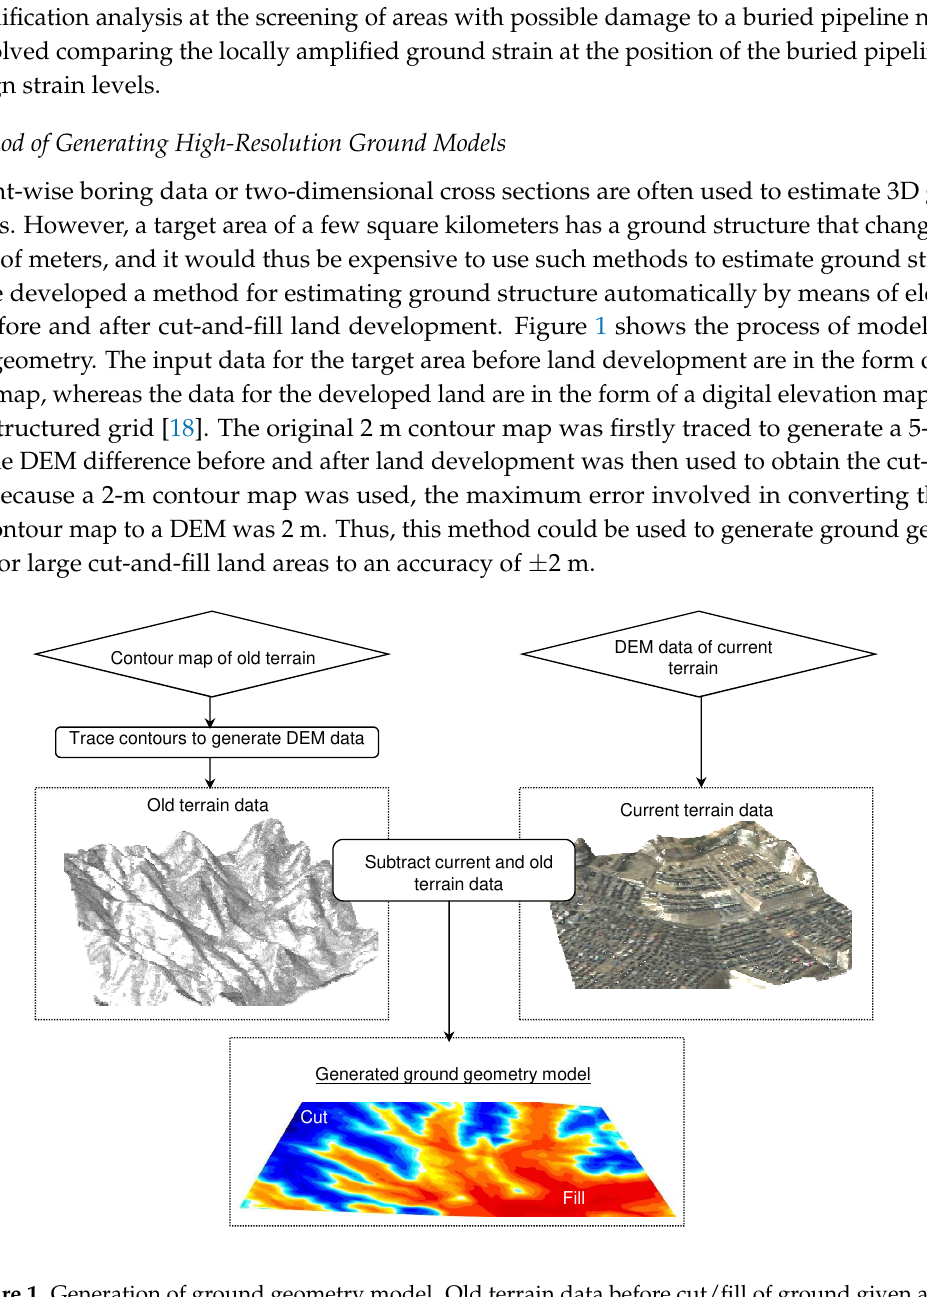
Figure 1. Generation of ground geometry model. Old terrain data before cut/fill of ground given as a contour map that was traced to make a digital elevation map (DEM). This was subtracted from a DEM of the current terrain to make a ground geometry model. Red in the generated ground geometry model indicate fill regions, while blue in the ground geometry model indicate cut